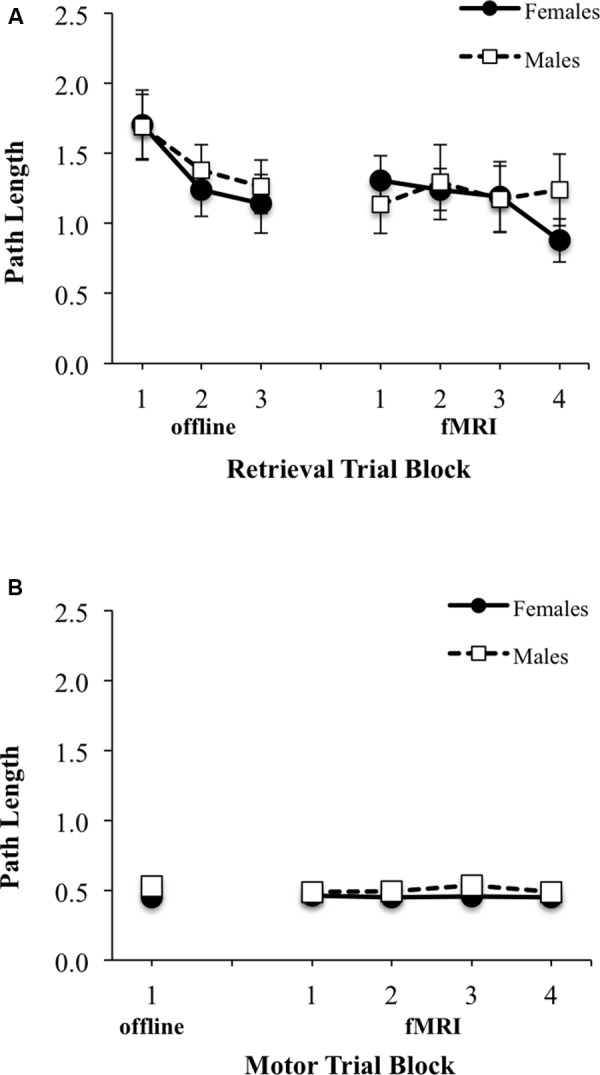
Path length (arbitrary units) from starting location relative to pool diameter during: (A) three offline (left) and four fMRI (right) retrieval/hidden trial blocks; (B) one offline (left) and four fMRI motor/visible trial blocks. Females are represented as filled black circles with solid lines and males are represented as open squares with dotted lines.